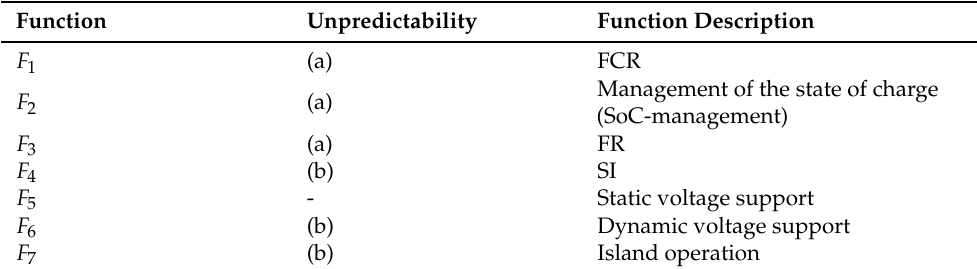
Table 3. Unpredictability of selected